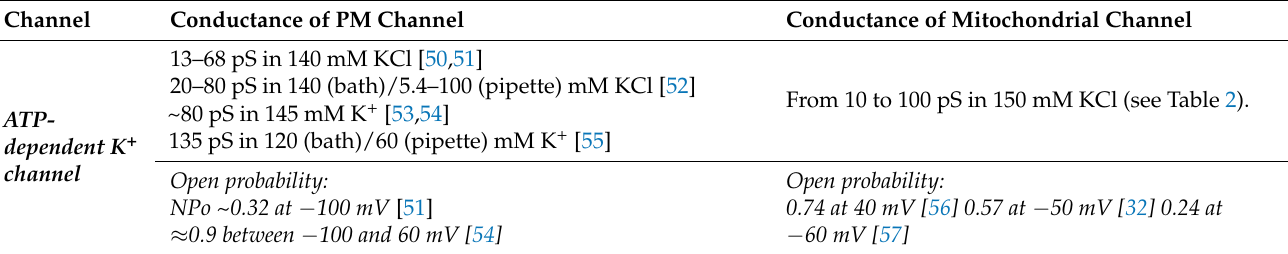
Table 1. Comparison of single-channel conductance values of the plasma membrane- and the inner mitochondrial membrane- located K + channels obtained by the patch-clamp technique (in excised inside-out or mitoplast-attached configurations). Open probabilities are also reported, where